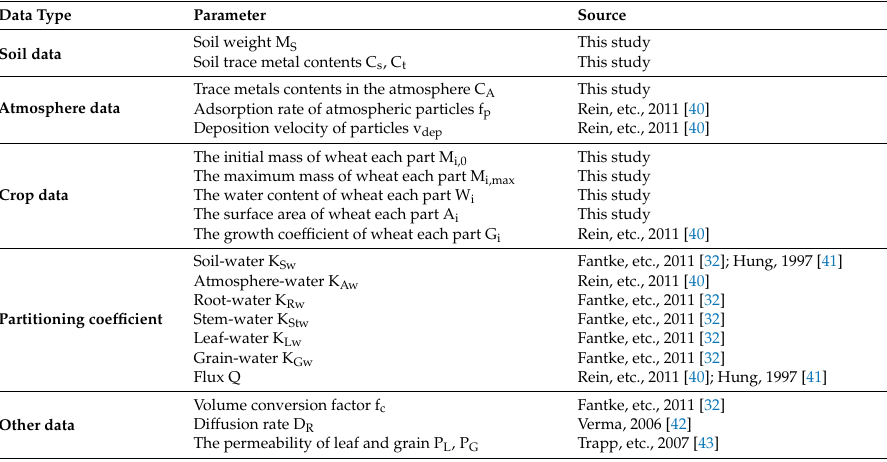
Table 2. Main parameters and